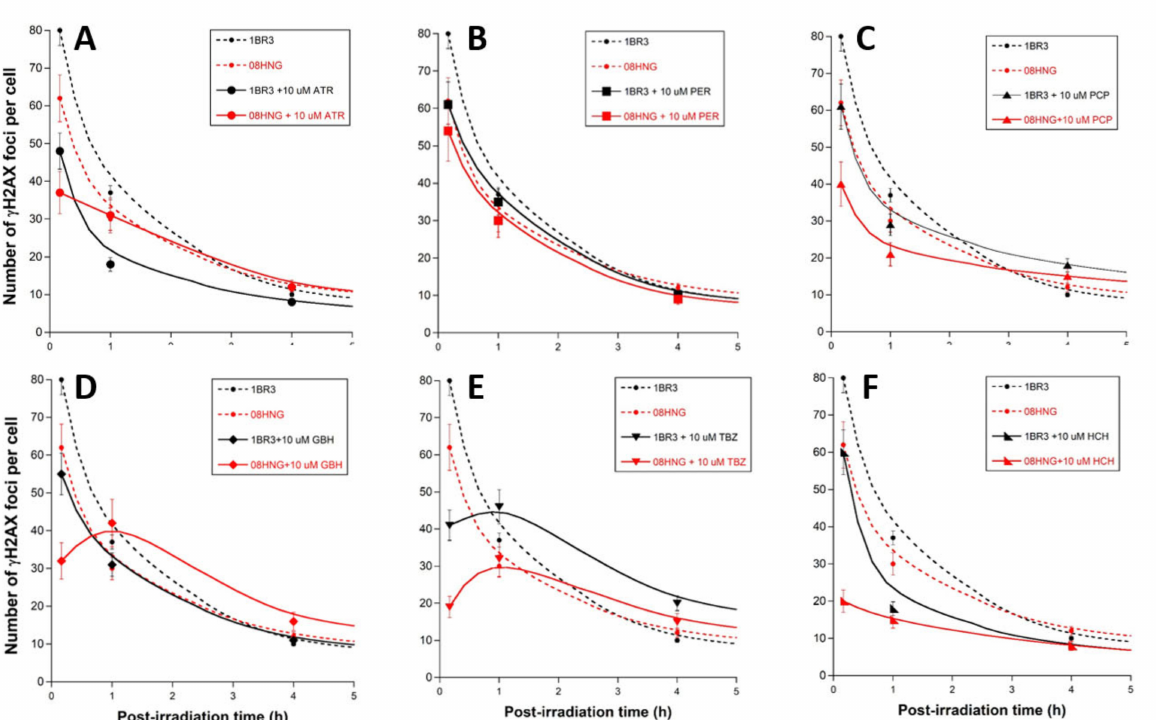
Figure 4. γ H2AX kinetics after exposure to pesticide and X-rays. Number of γ H2AX foci as a function of post-irradiation time in the human untransformed radio-resistant RIANS-normal 1BR3 (black plots) and RIANS-delayed 08HNG (red plots) fibroblasts incubated for 24 h, with the indicated concentrations of pesticides (solid line) or not (dotted line), and irradiated (2 Gy X-rays) thereafter (( A ): ATR; ( B ): PER; ( C ): PCP; ( D ): GBH; ( E ): TBZ; ( F ): HCH). Each plot represents the mean ± standard error (SEM) of 3 replicates. It is noteworthy that the 24 h data were not found to be dependent of the presence of pesticides before irradiation (data not